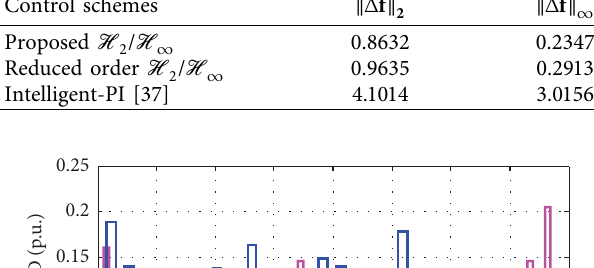
Figure 12: Sensitivity analysis’ graphs of the frequency deviations of the considered MG for diferent uncertainties in H and D .